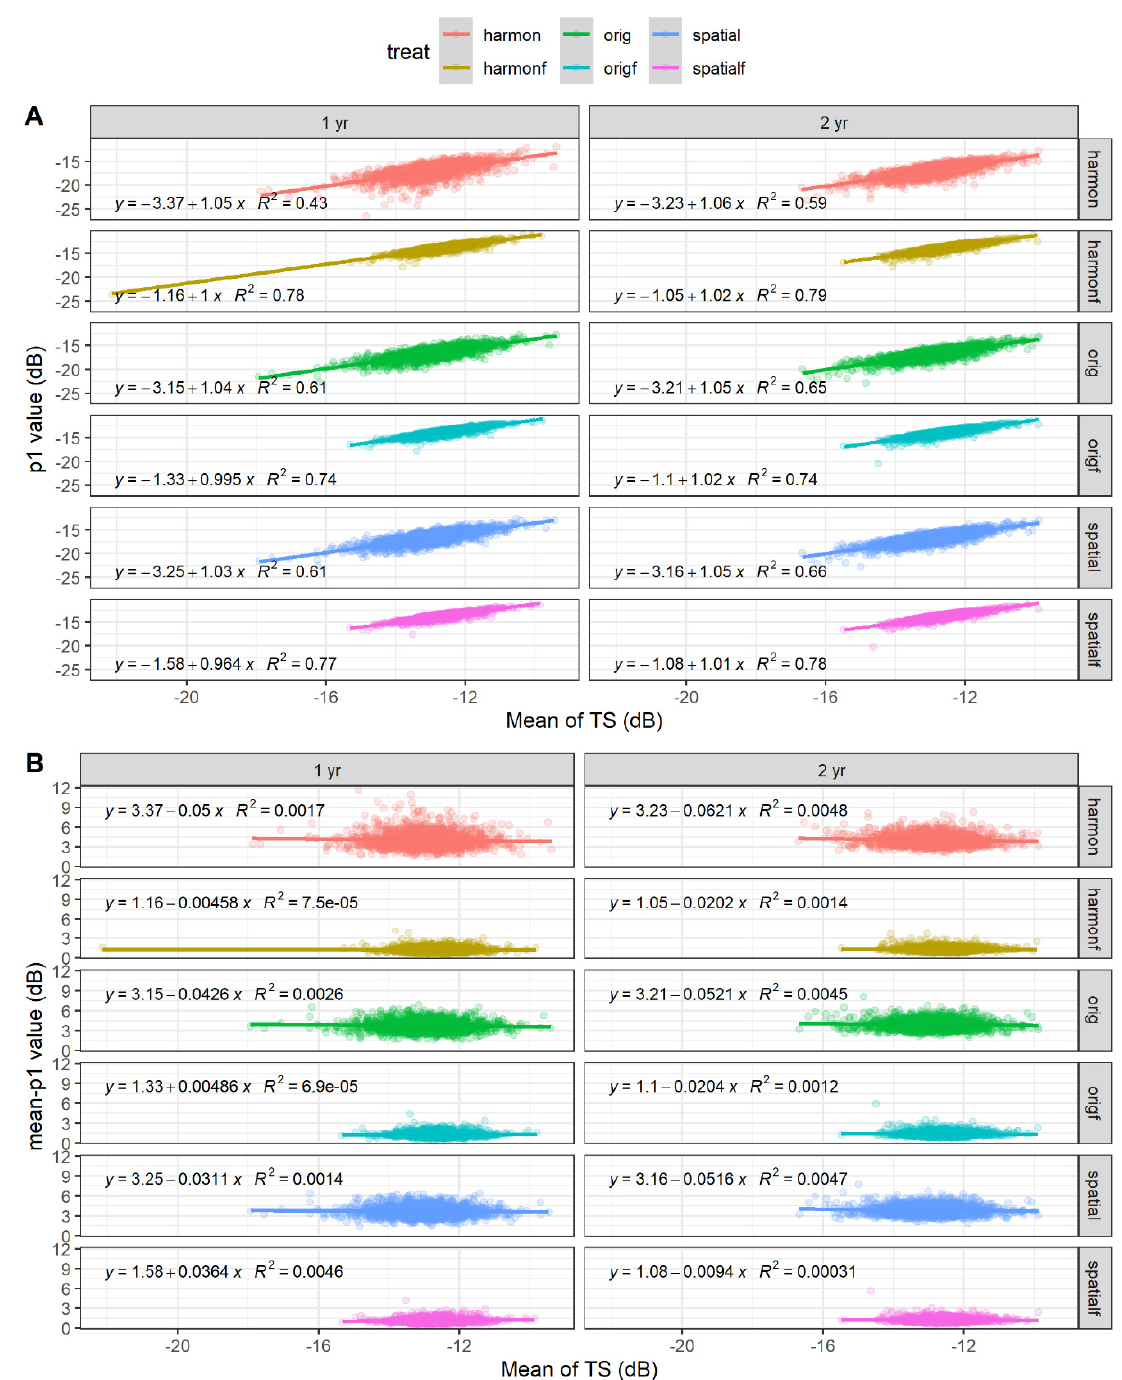
Figure 10. Relationship between the mean value of the forest VH backscattering and the minimum (p1) value of the time series in forest pixels ( A ). As an alternative analysis, chart ( B ) shows the relationship between the mean and the difference between the mean and the p1 value.